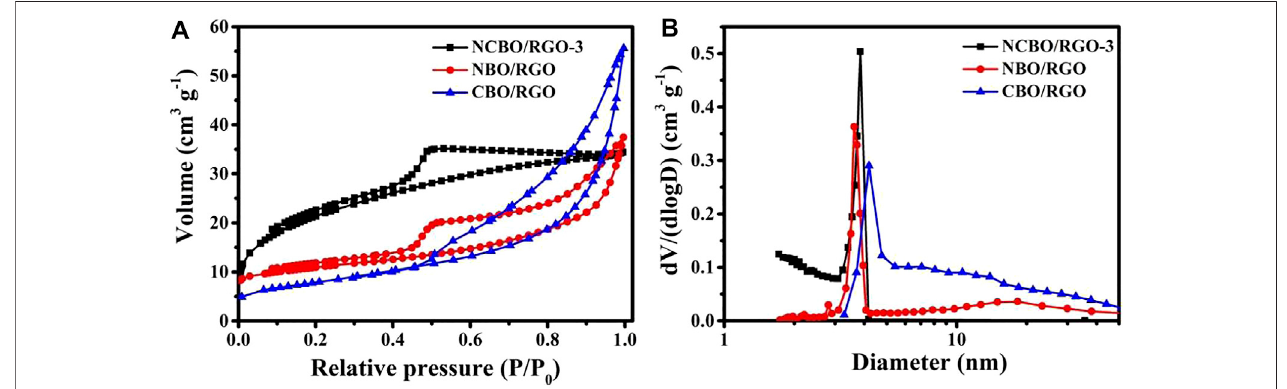
FIGURE 3 | (A) N 2 adsorption/desorption isotherms; (B) Pore size distributions of the three TMBO/RGO